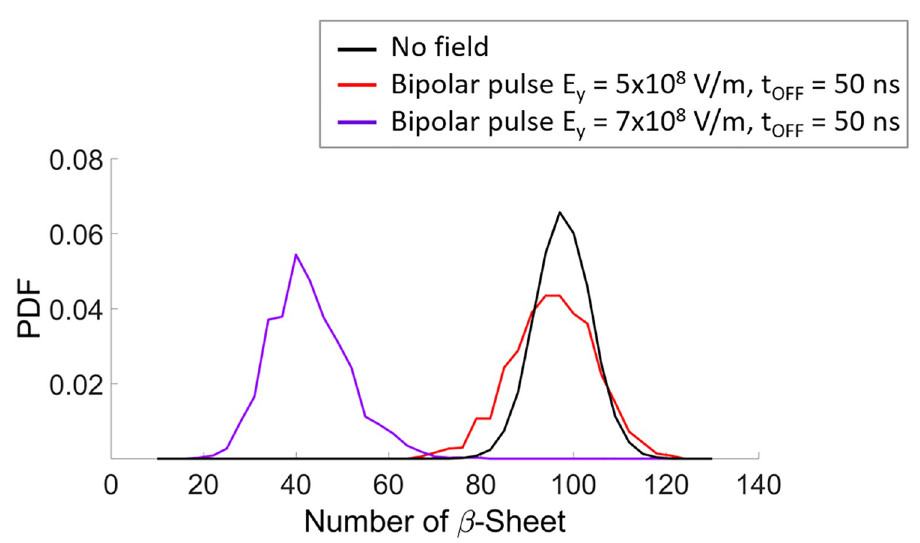
Fig 4. SOD1 secondary structures recovery. Probability density function of SOD1 β -Sheets during the OFF state (50 ns) after the BP (5x10 8 and 7x10 8 V/m) switch